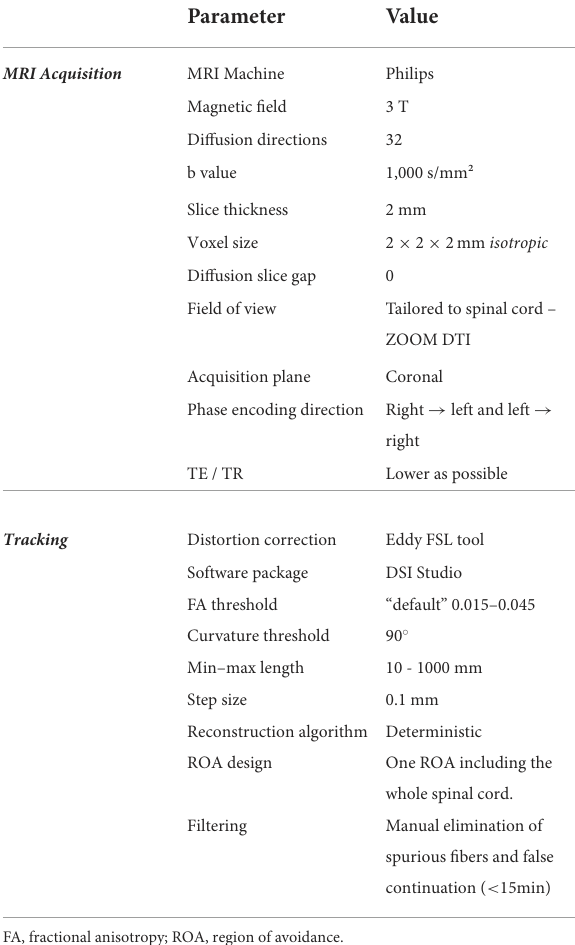
TABLE 1 Diffusion acquisition and tracking